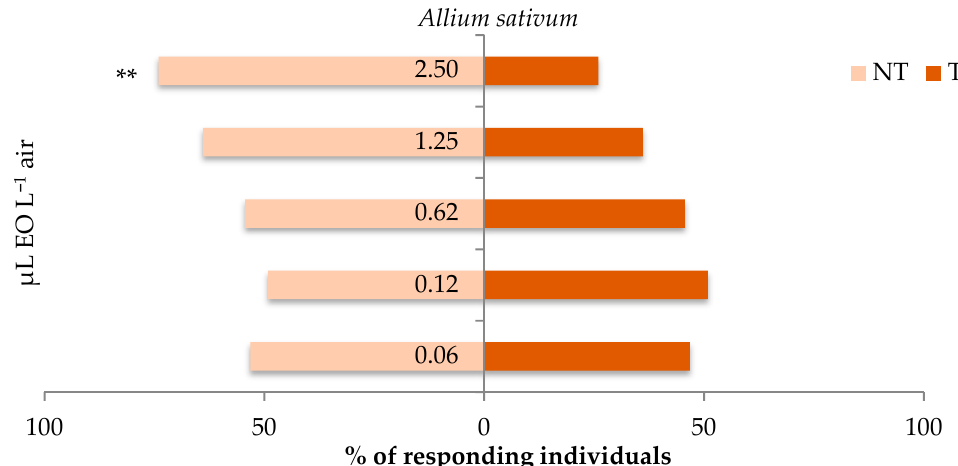
Figure 3. Behavioural response of the C. vomitoria adults in the presence of Aloysia citrodora, Bursera graveolens , and Allium sativum essential oils. NT, % of insects that chose the control chamber; T, % of insects that chose the EO-treated chamber. Asterisks indicate the significant effect of the EOs on the ratio of the adults choosing either the control or the EO-treated chamber ( χ 2 test; * p < 0.05; ** p < 0.01; *** p < 0.001).